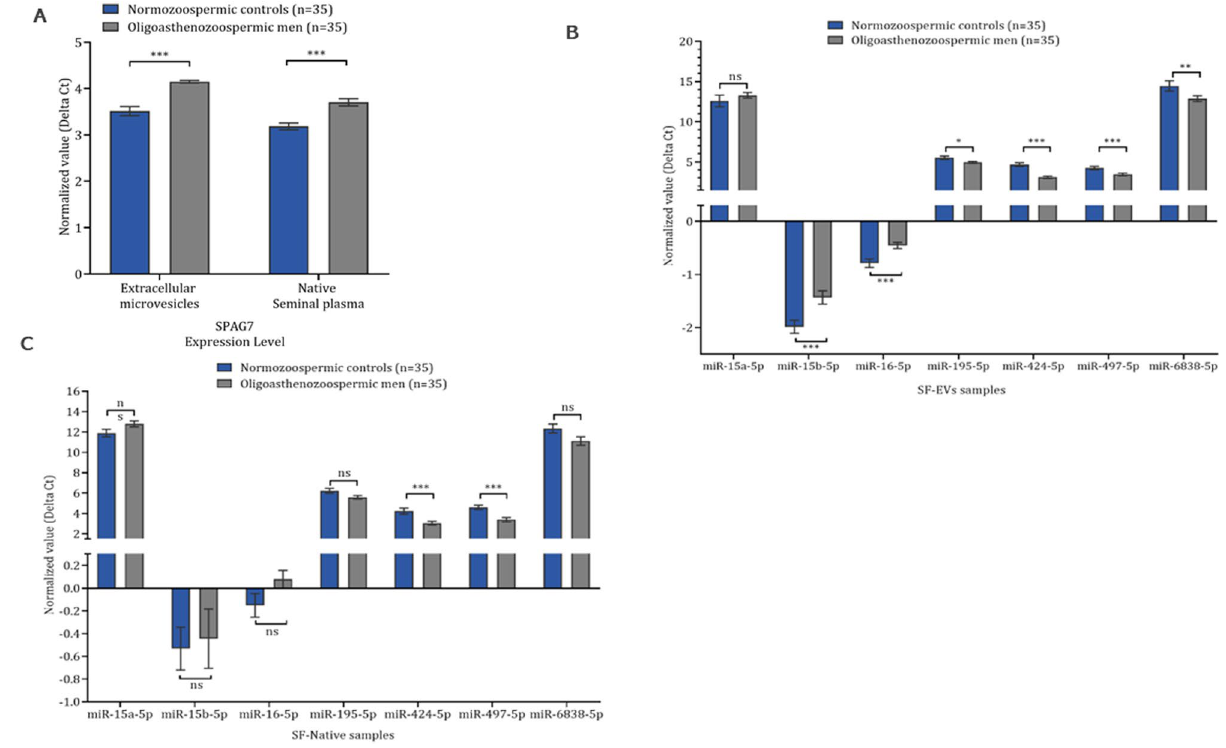
Figure 3. Expression levels of mRNA and seven miRNAs in oligoasthenozoospermic men and age-matched normozoospermic men as determined by RT-qPCR. ( A ) SPAG7 mRNA, ( B ) SF-EVs samples, and ( C ) SF-Native samples. Data are presented as the mean ΔCt of oligoasthenozoospermic and normozoospermic men (lower ΔCt, higher abundance level). GAPDH and global normalization were used as an endogenous control for the normalization of mRNA and miRNAs, respectively. Unpaired-two-tailed t-test and mean ± SEM were used to evaluate differences in expression level. P < 0.05 with FDR adjustment was considered statistically significant (* P < 0.05; ** P < 0.01; *** P < 0.001).